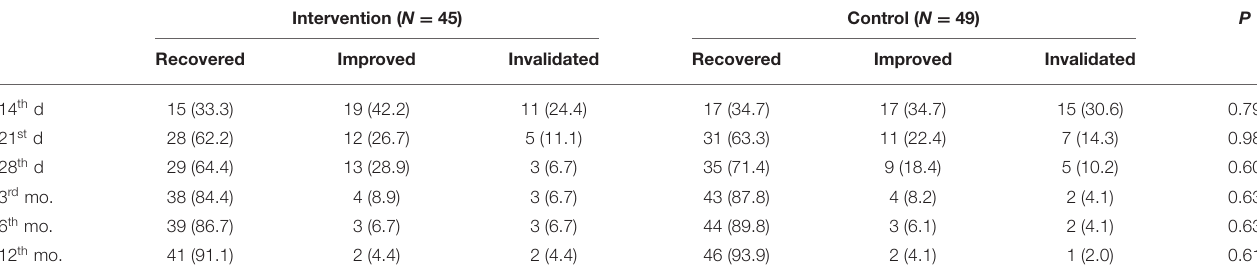
TABLE 3 | The recovery of urination function in different periods after